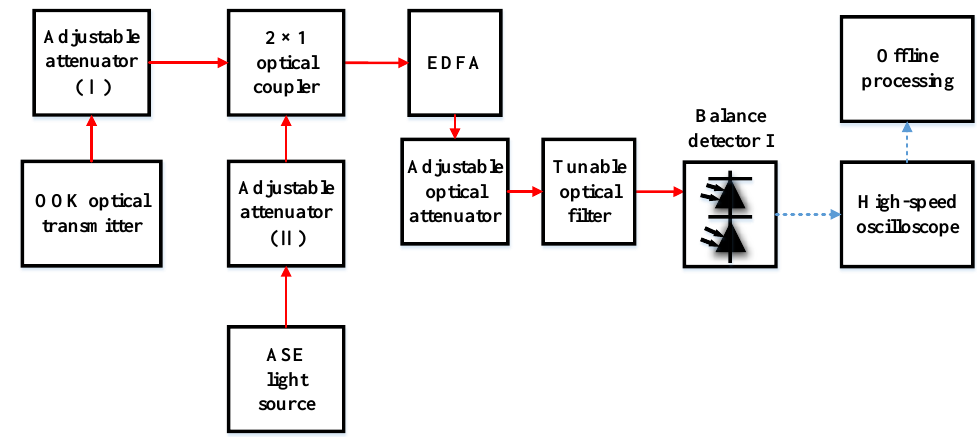
Figure 14. Experimental structure diagram of the influence of AL on OOK non-coherent reception. The central wavelength of the tunable filter was set as the optical signal wavelength, and the FWHM of the filter passband was set to 0.8 nm. The wavelength of the SAL output from the quency of 12 5.53 10 Hz . The SAL power was set to 1.03 μ W , 3.29 μ W , 6.58 μ W , 12.84 μ W , 25.68 μ W , and 51.35 μ W . With the EDFA, an additional 50% power loss was